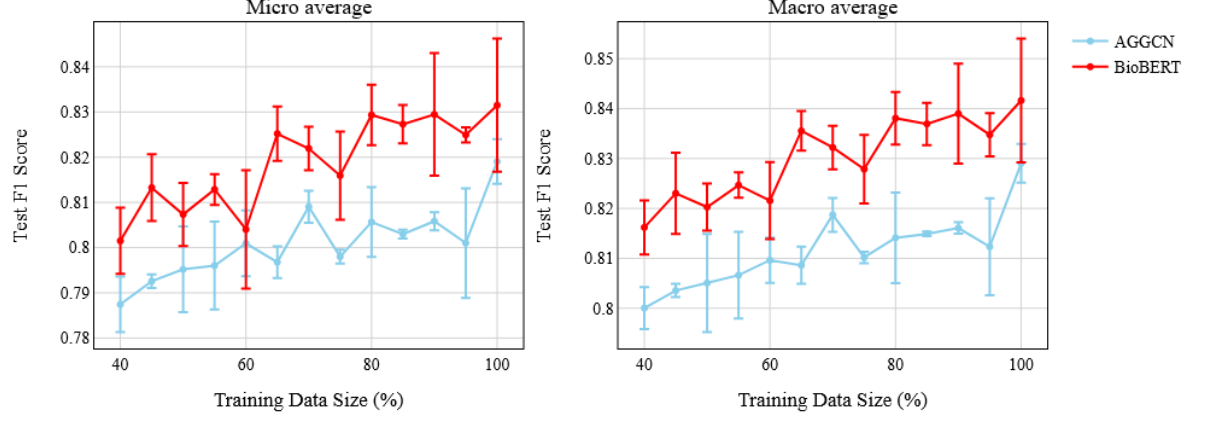
Figure 6. Effect of training data size on model performance. Each error bar indicates the standard deviation range at the corresponding point. AGGCN: attention-guided graph convolutional network; BERT: Bidirectional Encoder Representation from Transformers; BioBERT: BERT pretrained on biomedical